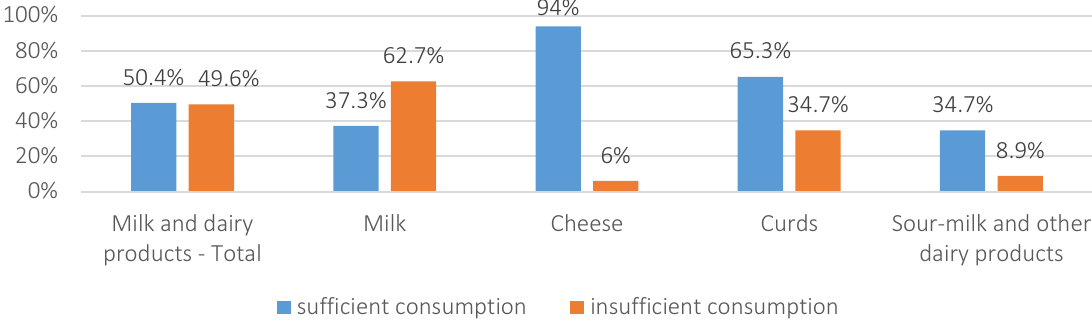
Figure 4. Annual consumption of milk and dairy products